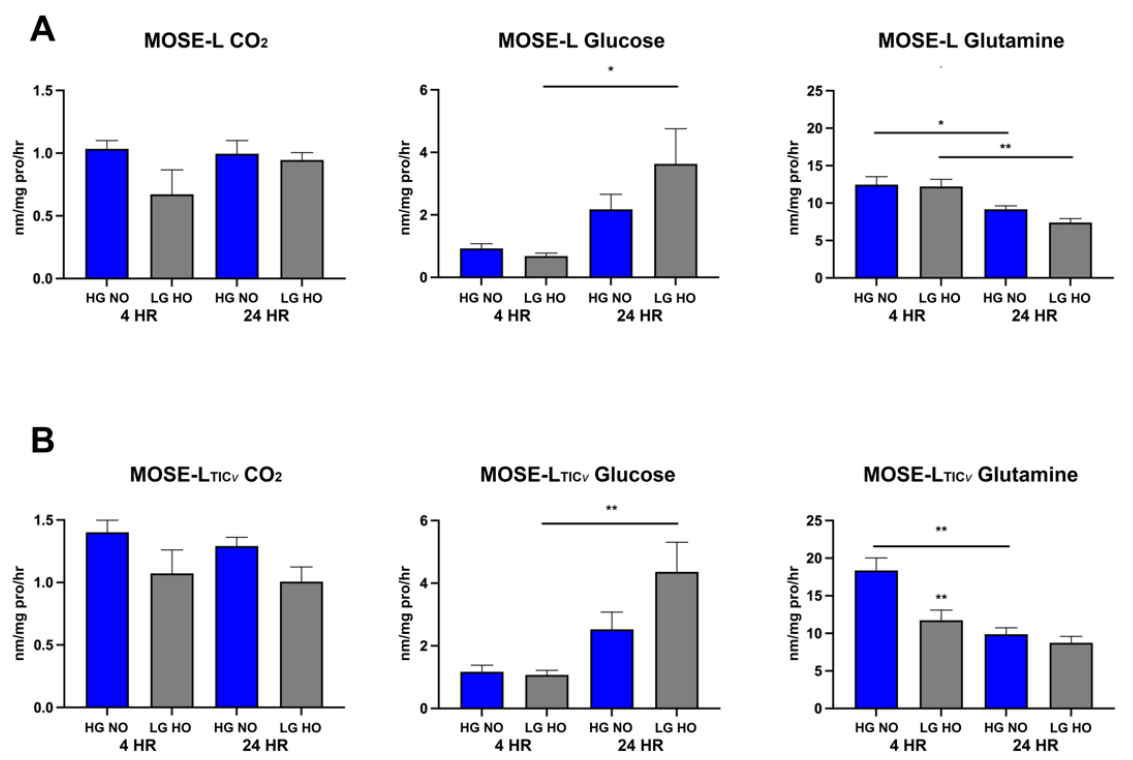
Figure 6. Substrate oxidation of 14 C-palmitic acid into CO 2 , 14 C-glucose, and 14 C-glutamine in HG NO and LG HO culture conditions in spheroids. ( A ) MOSE-L substrate oxidation ( B ) MOSE-L TIC v substrate oxidation at 4 and 24 h of adherence. Data are represented as the mean ± SEM. ** p < 0.01 compared to HG NO within the same time point; bars with * p < 0.05 compared to 24 h; bars with ** p < 0.01 compared to 24 h. Abbreviations: high glucose (HG); low glucose (LG); normoxia (NO); hypoxia (HO).